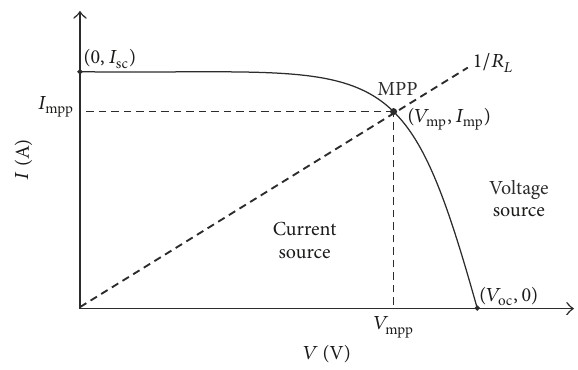
Figure 4: 𝐼 - 𝑉 characteristic of a practical photovoltaic